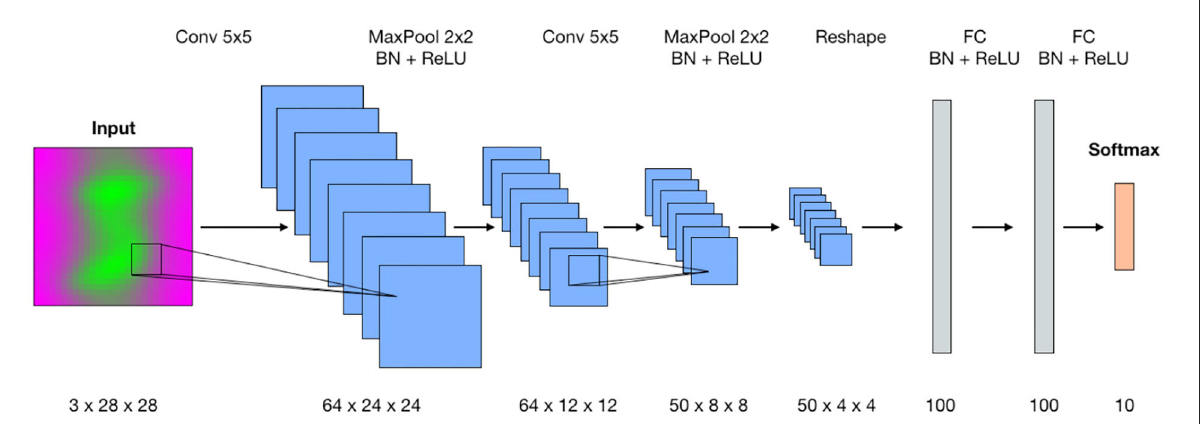
FIGURE3 The architecture of the convolutional neural network for digit classification. The proposed method operates in the data domain and does not require intervention into the existing training workflow.